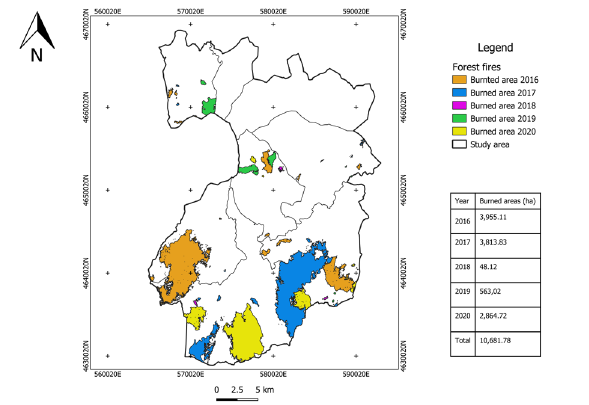
Figure 4 . Burned areas mapping.